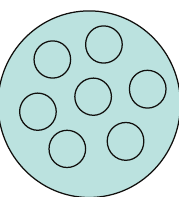
Figure 6: Cross sectional view of